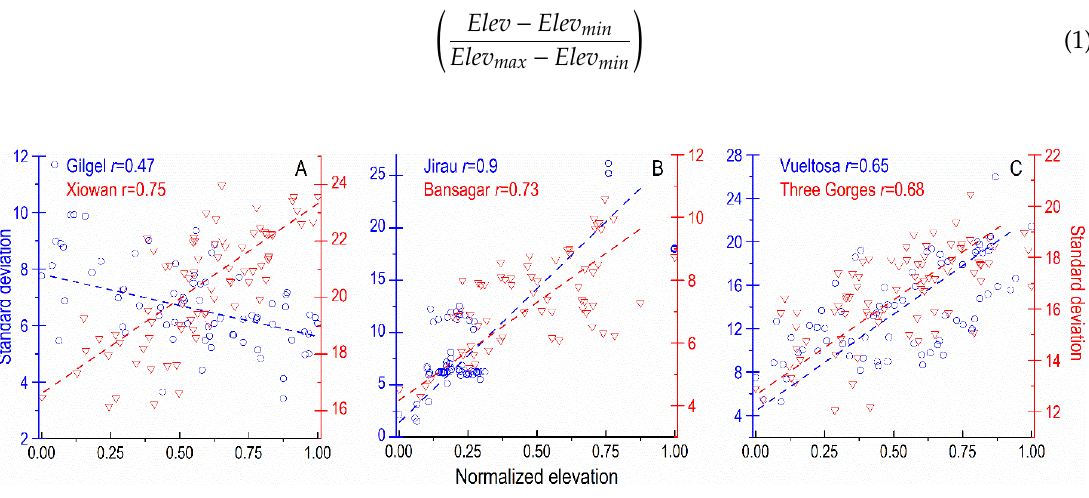
Figure 7. Standard deviation vs. normalized elevation showing positive relationships except for for Gilgel Gilgel reservoir.